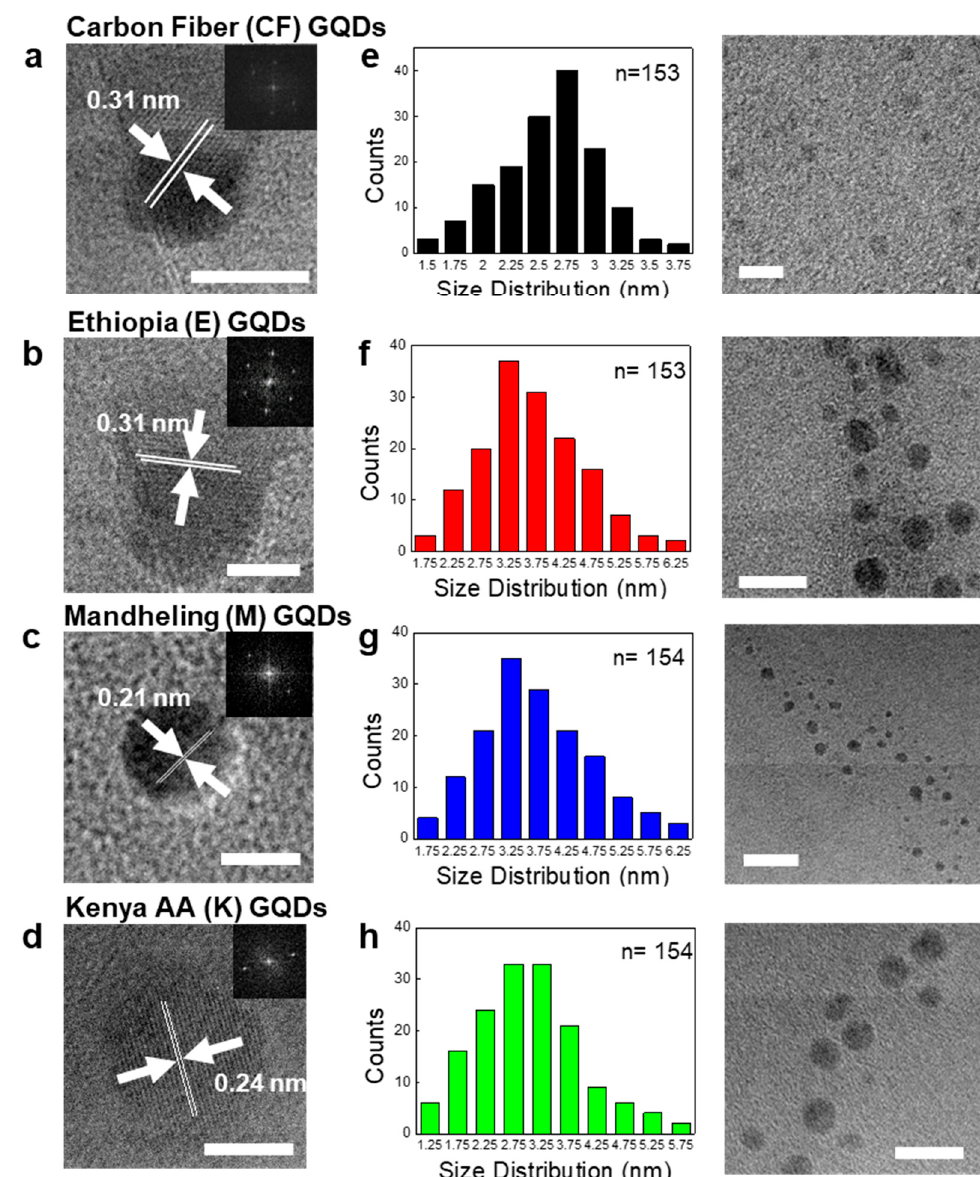
Figure 2. TEM images, size distributions of the coffee bean-derived GQDs. ( a – d ) Representative HR-TEM images of the carbon fiber-derived GQDs and the coffee bean GQDs with inter-layer spacing (scale bar = 5 nm). The SAED patterns are shown in the inset. ( e – h ) Representative size distributions of carbon fiber-derived GQDs and the coffee bean GQDs.